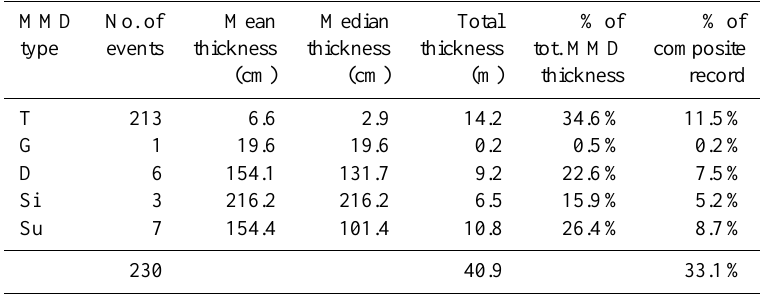
Table 1. A summary table of Quaternary MMDs in Lake El’gygytgyn (T=turbidite, G=grain-flow deposit, D=debrite, Si=slide, Su=slump). MMD No. of Mean Median Total % of % of type events thickness thickness thickness tot. MMD composite (cm) (cm) (m)